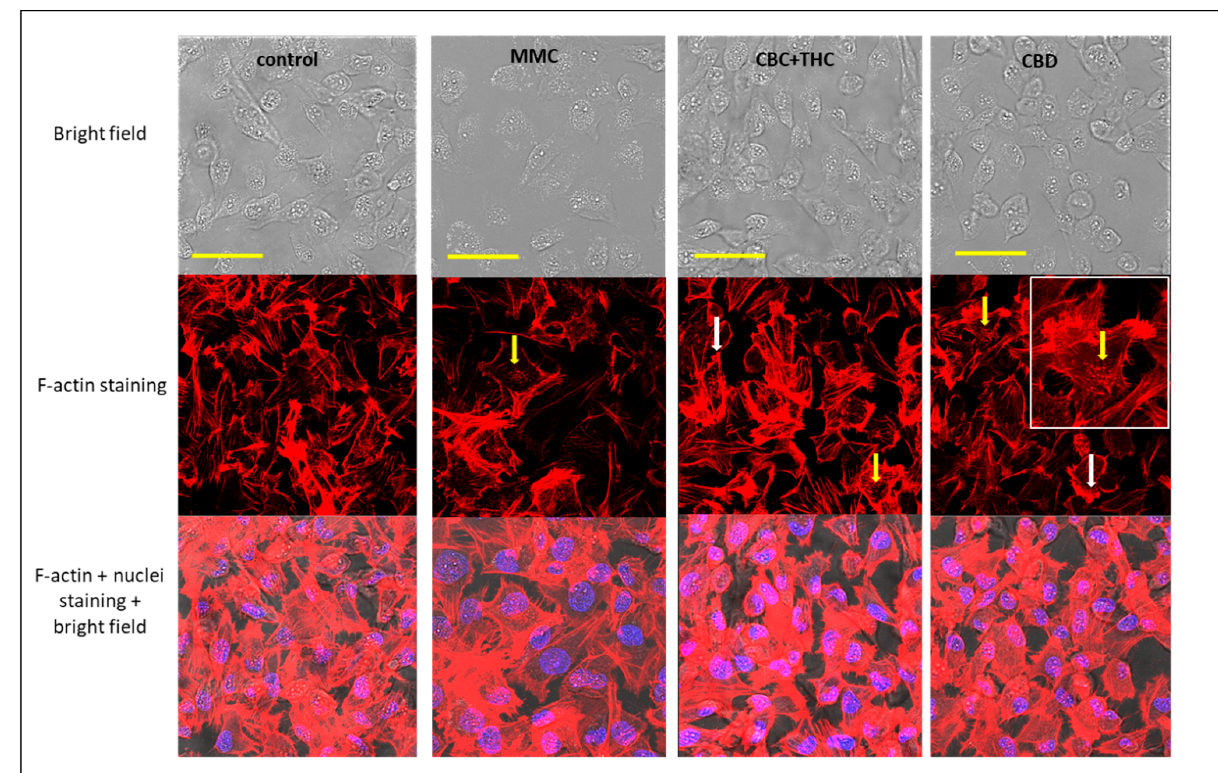
Figure 6. Confocal images of T24 cells following treatment with methanol (the vehicle control), Mitomycin-C (MMC, 4 µg/mL) as positive control, CBC + THC (8.6 + 1.4 µg/mL, respectively) and CBD (10 µg/mL) on T24 cell line for 24 h. F-actin (EasyProbes™ ActinRed 555 Stain, red stain), and nuclei (Hoechst, blue stain) were stained. Bars = 50 µm; yellow arrows point to disintegration of F-actin filaments visualized as characteristic spots; white arrows point to induced accumulation of F-actin filaments on the cell periphery.